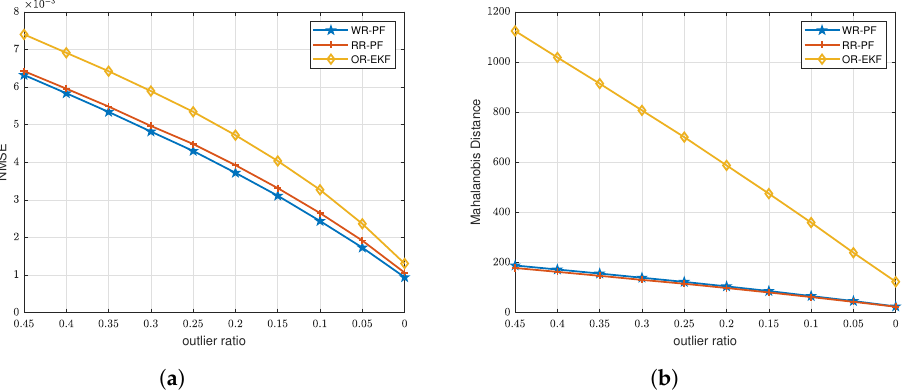
Figure 6. Estimated errors versus only range outliers in multidimensional measurements. ( a ) NMSE comparisons. ( b ) Mahalanobis distance comparisons.